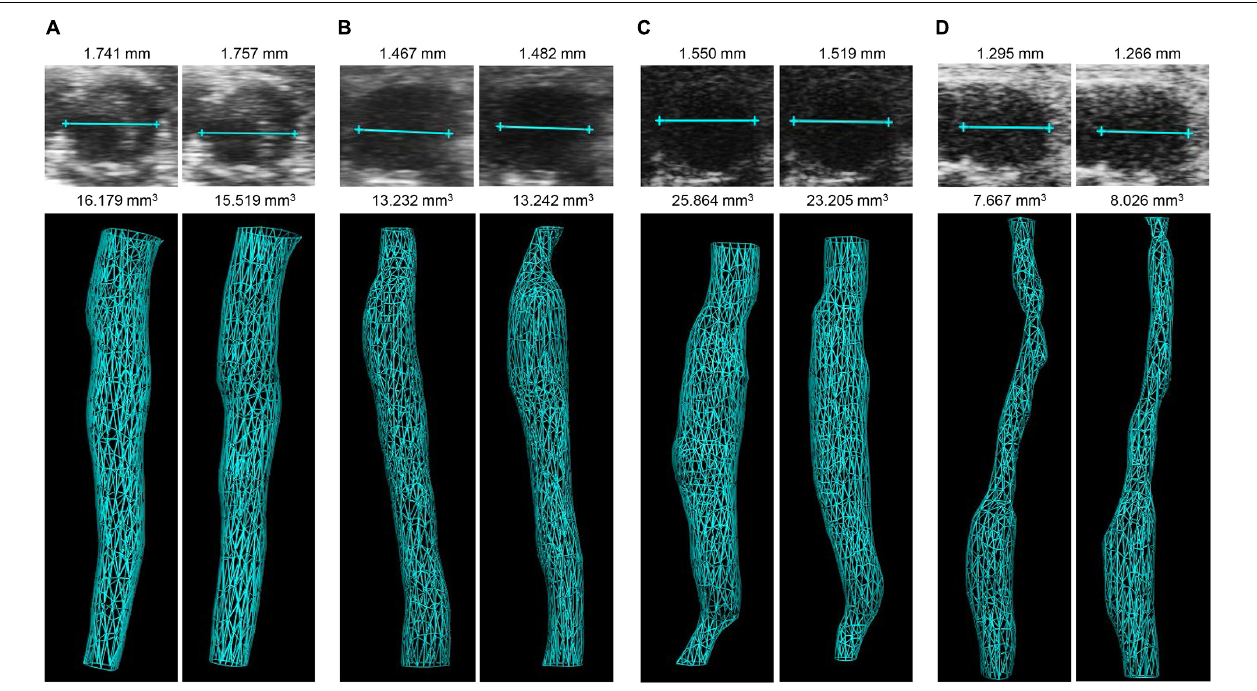
FIGURE 2 | Illustration of 3D volume and maximum aortic diameter measurements in four AAA mouse models by two independent observers. Examples are given for diameter (upper panel) and 3D reconstructed volume (lower panel) in the (A) AngII model, (B) ePPE model, (C) ePPE + BAPN model, (D) PPE model, as assessed by observer 1 (left) and observer 2 (right). Of note, 3D vascular images represent inner lumen. In case of the AngII model thrombi were included in the aortic wall tracing.